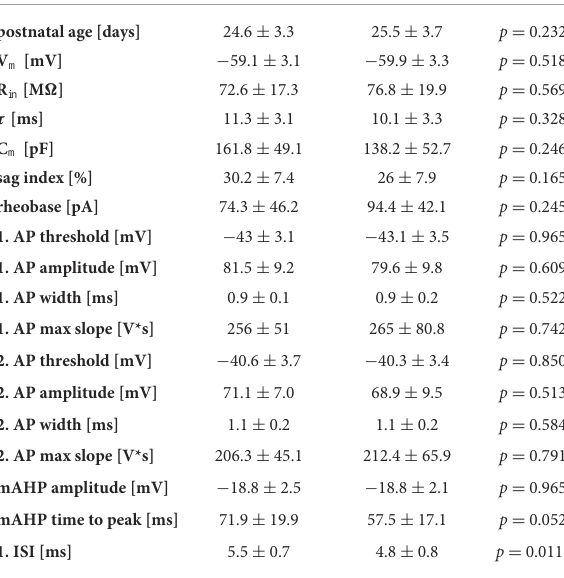
TABLE 1 Basic subthreshold and suprathreshold electrophysiological properties of RB pyramidal cells of WT and reeler